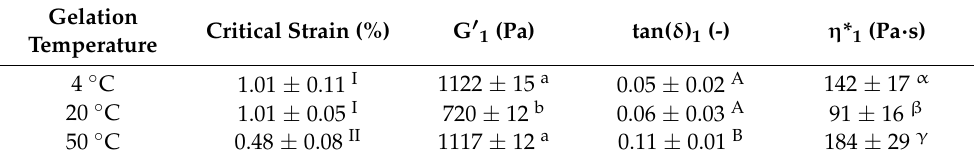
Table 3. Strain and frequency sweep tests parameters (mean value + standard deviation) for chitosan hydrogels processed at different gelation temperatures (4, 20 and 50 ◦ C). G (cid:48) 1 : elastic modulus at 1